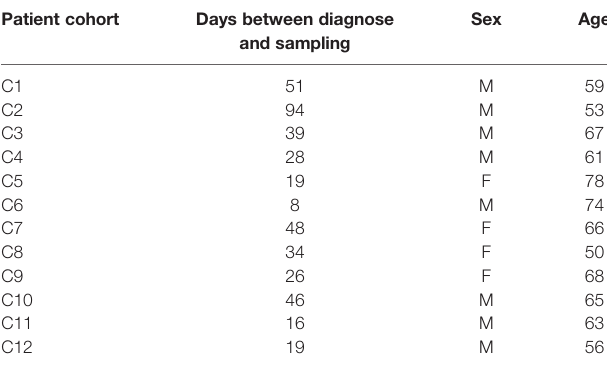
TABLE 1 | Demographic data of SARS-CoV-2 infected patients. Patient